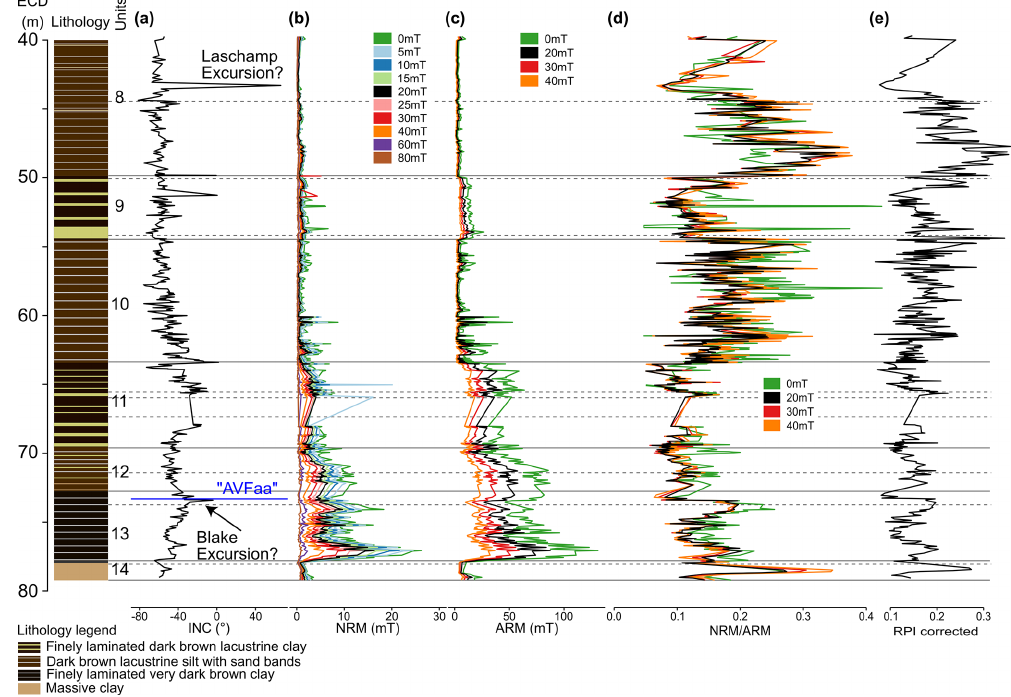
Figure 6. (a) Inclination, (b) NRM at different demagnetisation steps, (c) ARM at different demagnetisation steps, (d) NRM / ARM at differ- ent demagnetisation steps, and (e) facies-corrected relative palaeo-intensity (RPI) derived from NRM / ARM at 20mT of the Orakei sediment sequence. Horizontal grey lines mark facies unit boundaries (solid) and sub-unit boundaries (dashed) from Peti and Augustinus